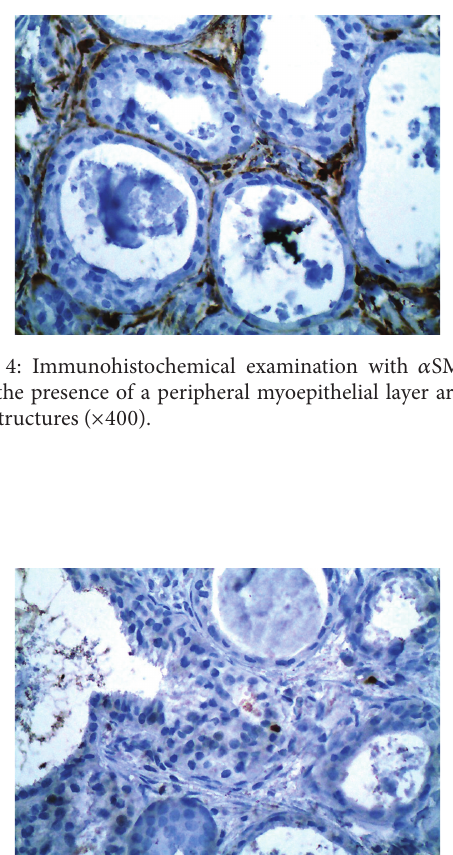
Figure 2: Apocrine metaplasia was evident throughout the lesion ( × 400).